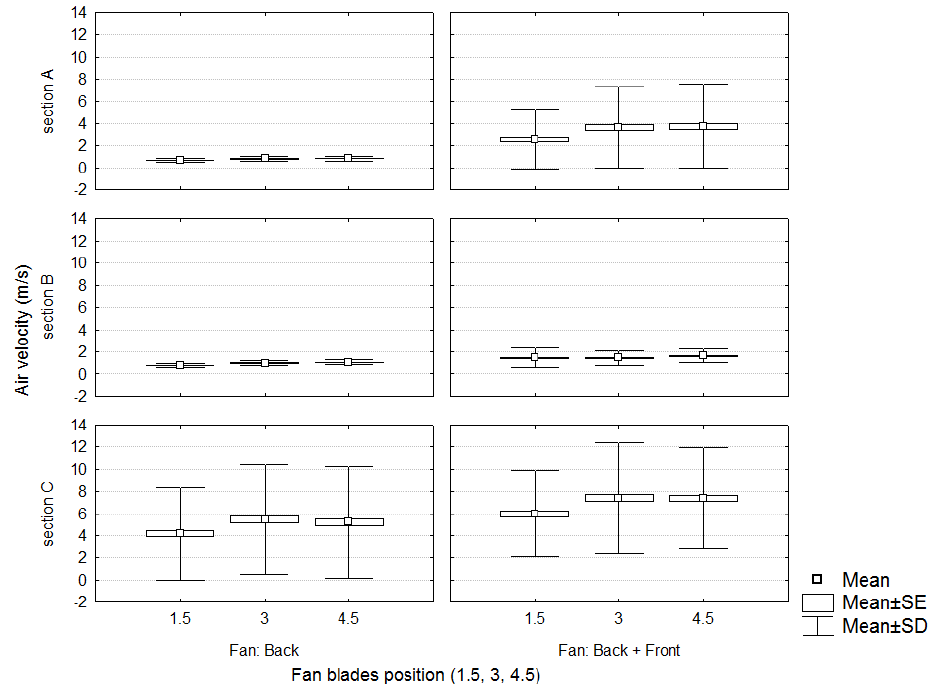
Figure 6. Static test. Air velocity values in the sample sections depending on the number of active fans and the air flow